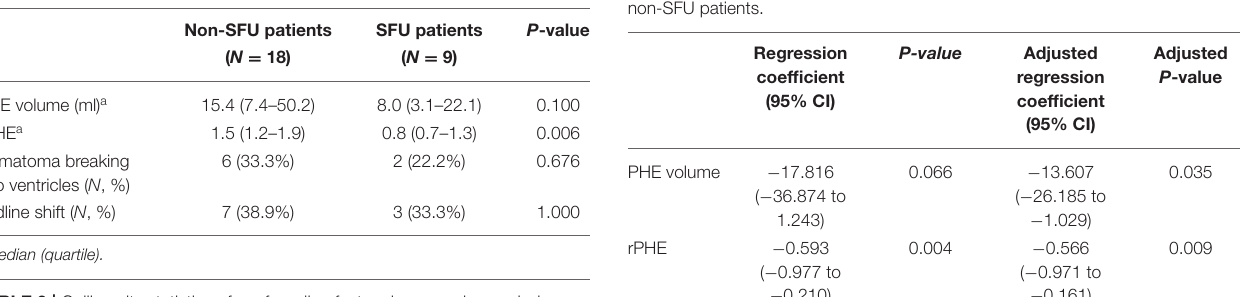
TABLE 3 | Collinearity statistics of confounding factors in regression analysis.